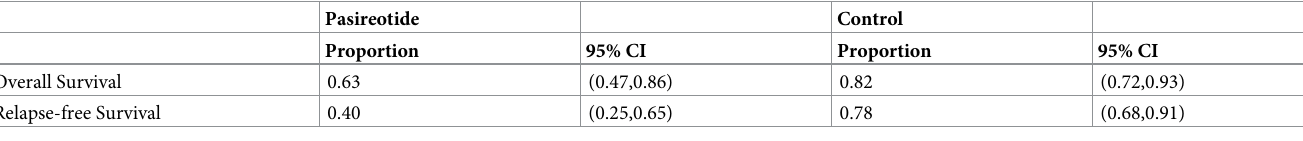
Table 2. 1-year survival proportion with confidence